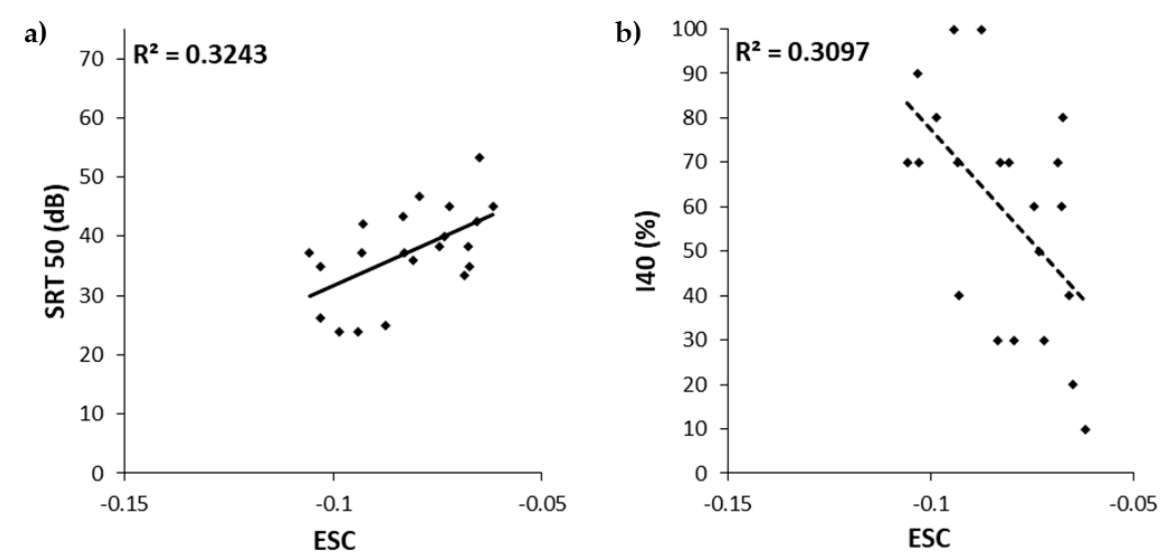
Figure 5. Scatter plots of the 50% speech reception threshold (SRT50, ( a )) and the intelligibility at 40 dB (I40, ( b )) as a function of the exponential spread coefficient (ESC) in the 21 subjects with all electrodes activated. Bravais-Pearson determination coefficients are indicated in the upper left